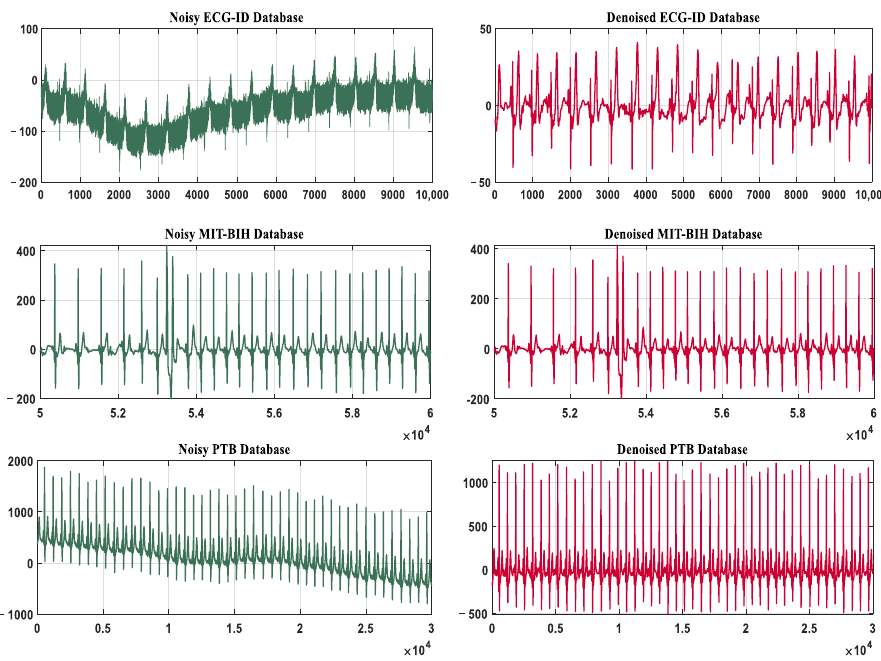
Figure 10. Denoising effect of three different databases.